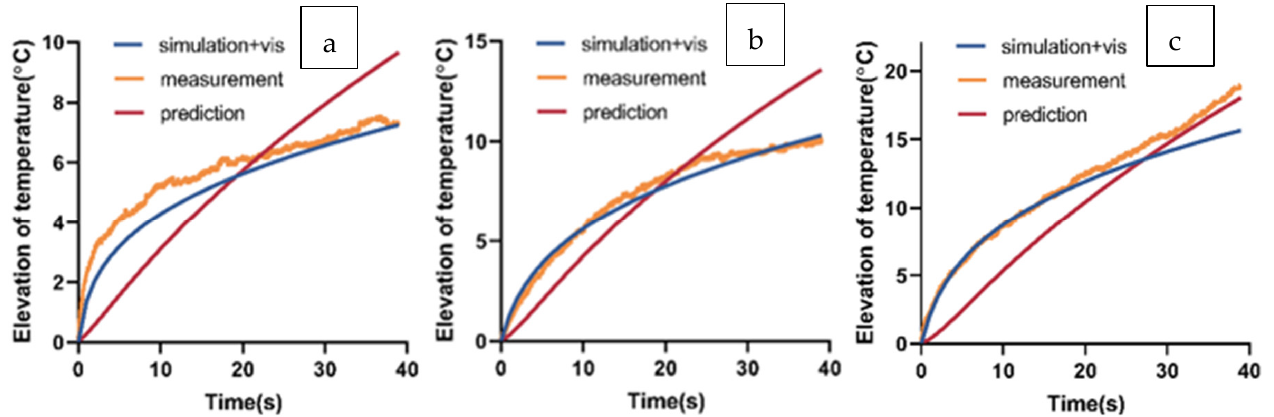
Figure 6. Temperature elevations at 1.5 mm away from the focus ( a ) 4 W, ( b ) 6 W, and ( c ) 8 W. The yellow solid lines present the measured temperature (measurement). The blue solid lines present the simulated temperature considering viscous heating (simulation + vis). The red solid lines present the predicted temperature (without glass and without VH) in the pure bovine liver (prediction).